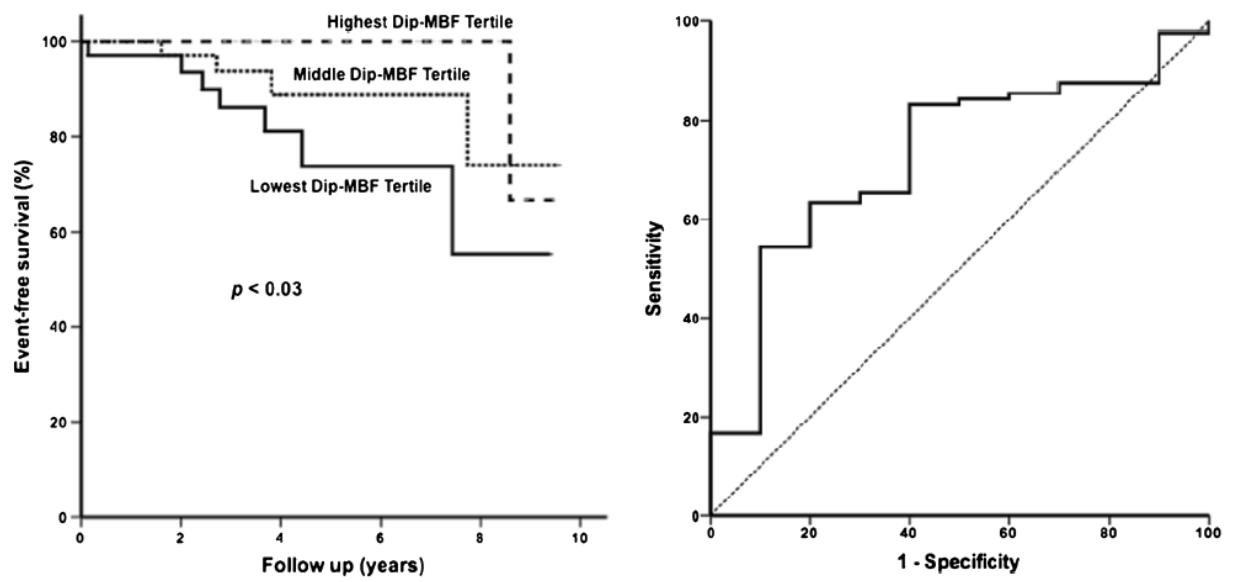
Figure 3. Myocardial blood flow (MBF) values after dipyridamole infusion and long-term prognosis. Survival analysis showed a significant increase in risk associated with lower Dip-MBF tertiles (right panel). ROC curve analysis identified a Dip-MBF < 1.35 mL/min/g as the best threshold for prediction of and unfavorable outcomes (left panel). The figure is from Castagnoli H et al., with permission [45].